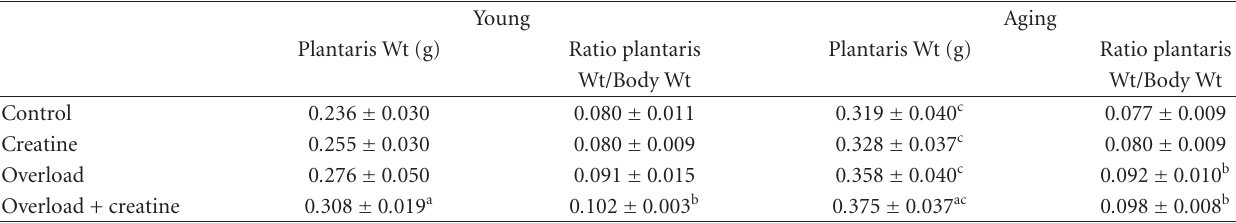
Table 3: Plantaris muscle weight and muscle weight/body weight ratio for young and aging